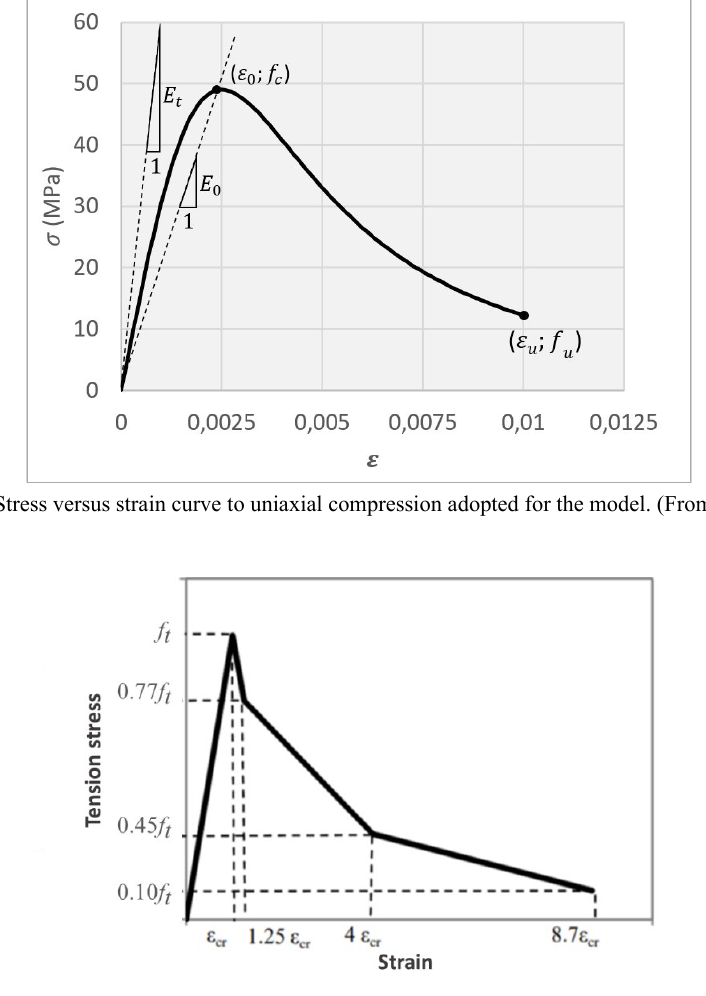
Figure 5. Constitutive relation for concrete (Adapted from Wahalathantri et al. [14]).